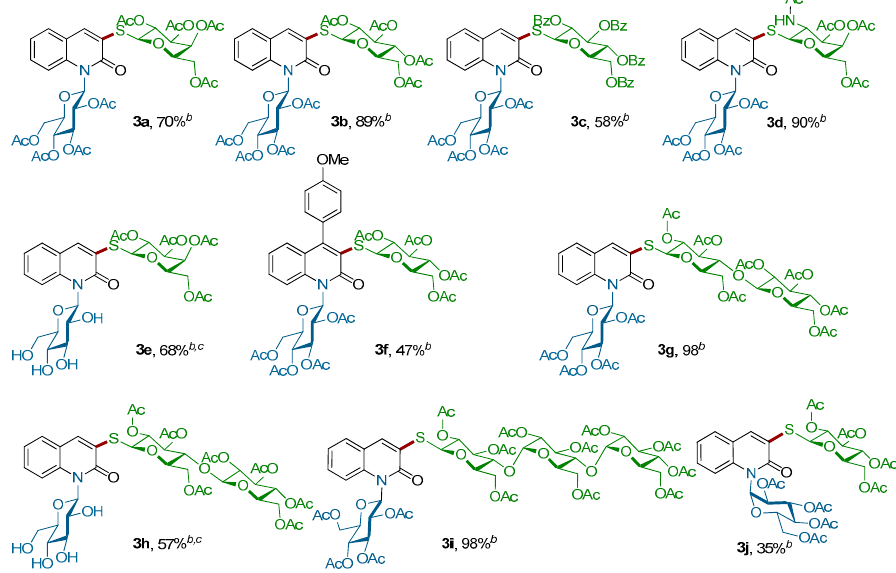
Figure 2. Scope of thiosugars 1a – f for the Pd-catalyzed coupling with N -glucosylquinolinones 2d – g a . a Conditions: Reactions of 1 (2.5 equiv.) with 2 (1.0 equiv.) were performed in a resealable tube by using Pd-G3-XantPhos (5 mol %) and Et 3 N (1.5 equiv.) in 1,4-dioxane (0.1 M) at room temperature for 3 h; b Yield of isolated; c THF:H 2 O (8:2) was used as a solvent.